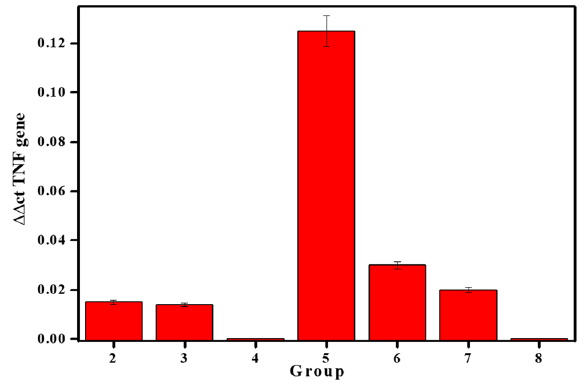
Figure 6. Genes expression of TNF of studied groups during the experimental